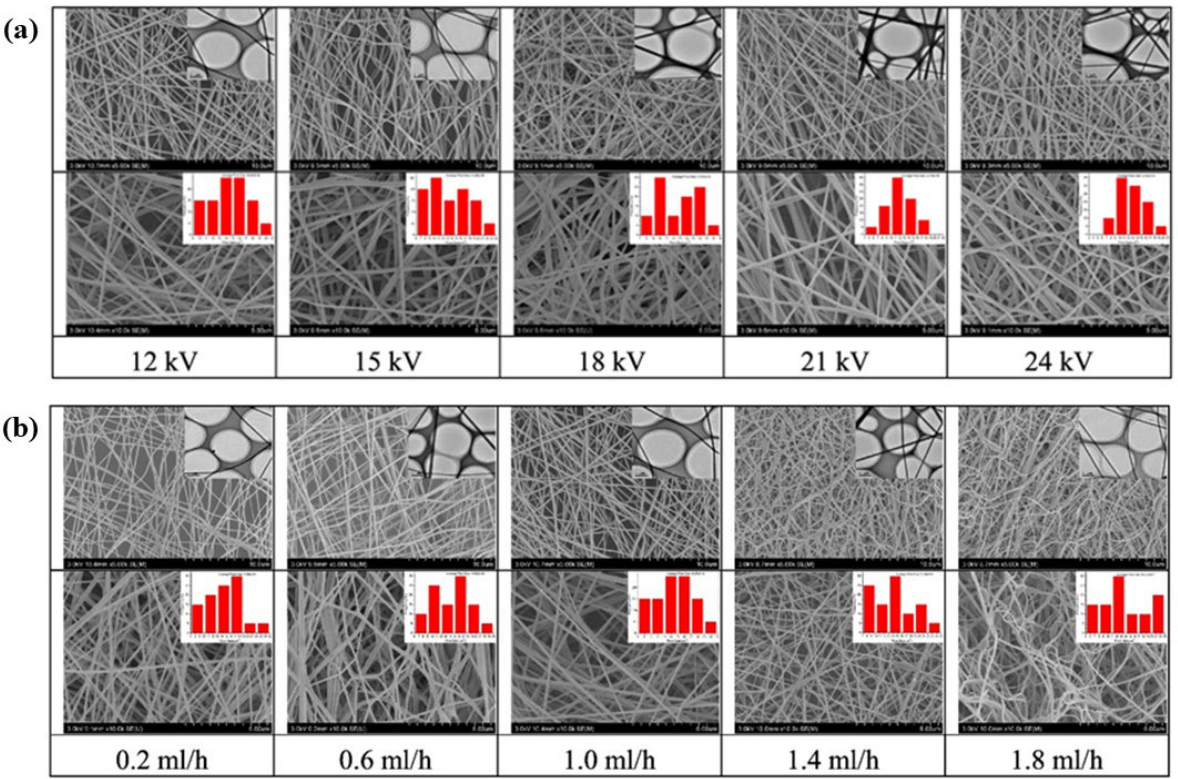
Figure 2. ( a ) SEM and TEM images of NFM at different voltages (the inset is the hole diameter distribution map). ( b ) SEM and TEM images of ENM at different flow rates (the inset is the pore diameter distribution map). Reprinted from ref. [39] .